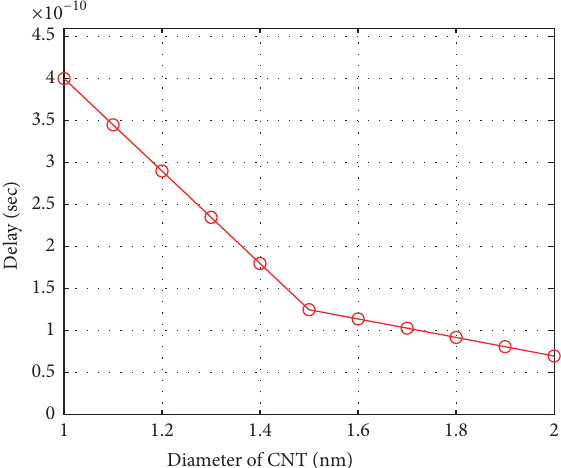
Figure 1: Effect of CNT diameter on the current.